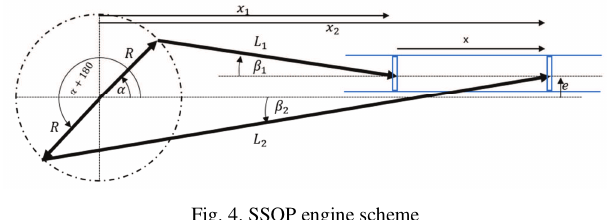
Fig. 4. SSOP engine scheme